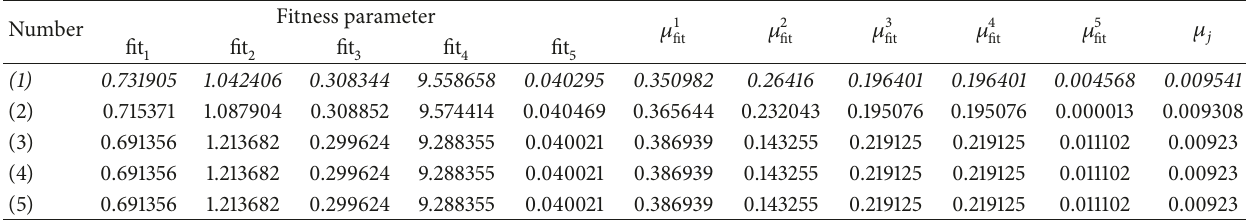
Table 6: The five best solutions based on the highest 𝜇 𝑗 using fuzzy approach for 137 sets of solutions (sampling time = 63).